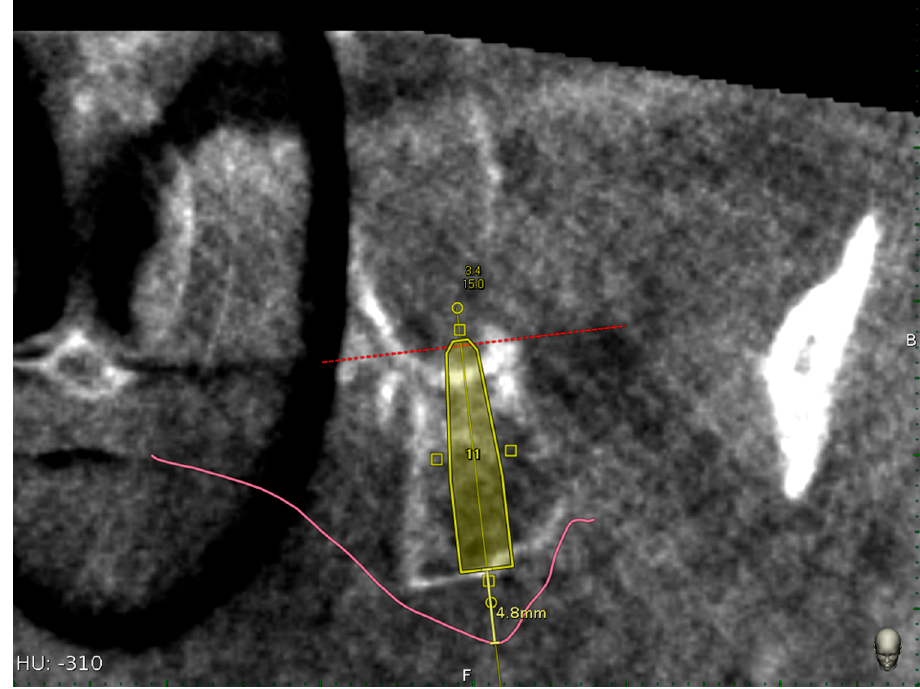
Figure 10. Mucosa thickness linear measurement using the implant centric view of the CBCT.